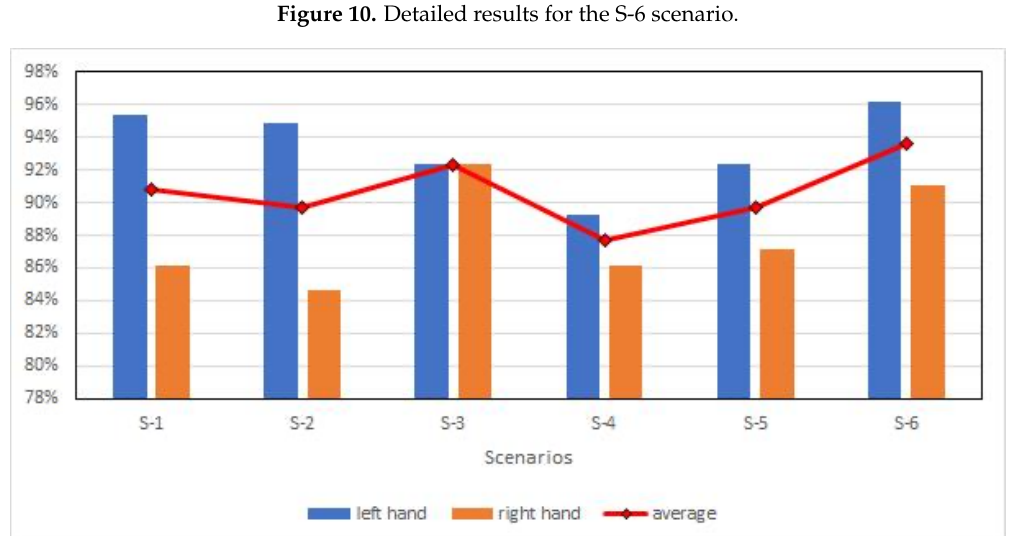
Figure 11. Accuracy of gesture recognition by